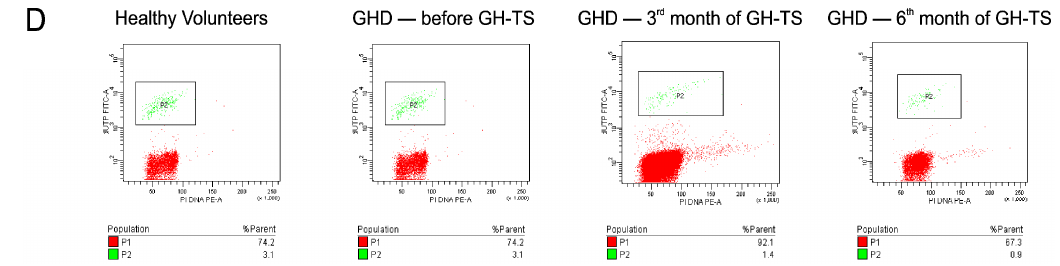
Figure 3. Detection of early and late phase of apoptosis in CD34+ cells from GHD patients. The percentage of CD34+ cells in the early ( A ) and late ( C ) phase of apoptosis was evaluated in control subjects and GHD patients at different time points (before GH-TS, and in the 3rd and 6th months of GH-TS). The results are expressed as the mean value ± S.D. * p < 0.05; ** p < 0.01 vs. GHD patients prior to GH therapy; Representative flow cytometric quadrant plots for the Annexin V/PI ( B ) and dot plots for the DNA fragmentation ( D ) analysis in CD34+ cells harvested from PB of healthy controls and GHD patients before GH-TS and in the 3rd and 6th month of GH-TS are shown.